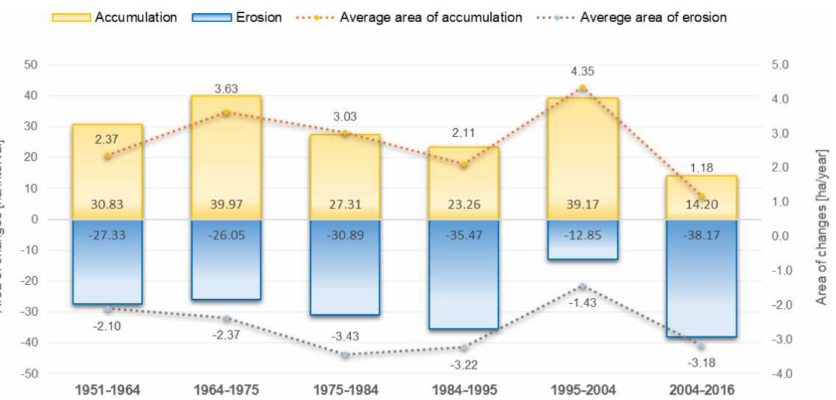
Figure 6. Graph of the changes in accumulated and eroded areas [ha] from 1951–2016 and the average area [ha] per year (188–218